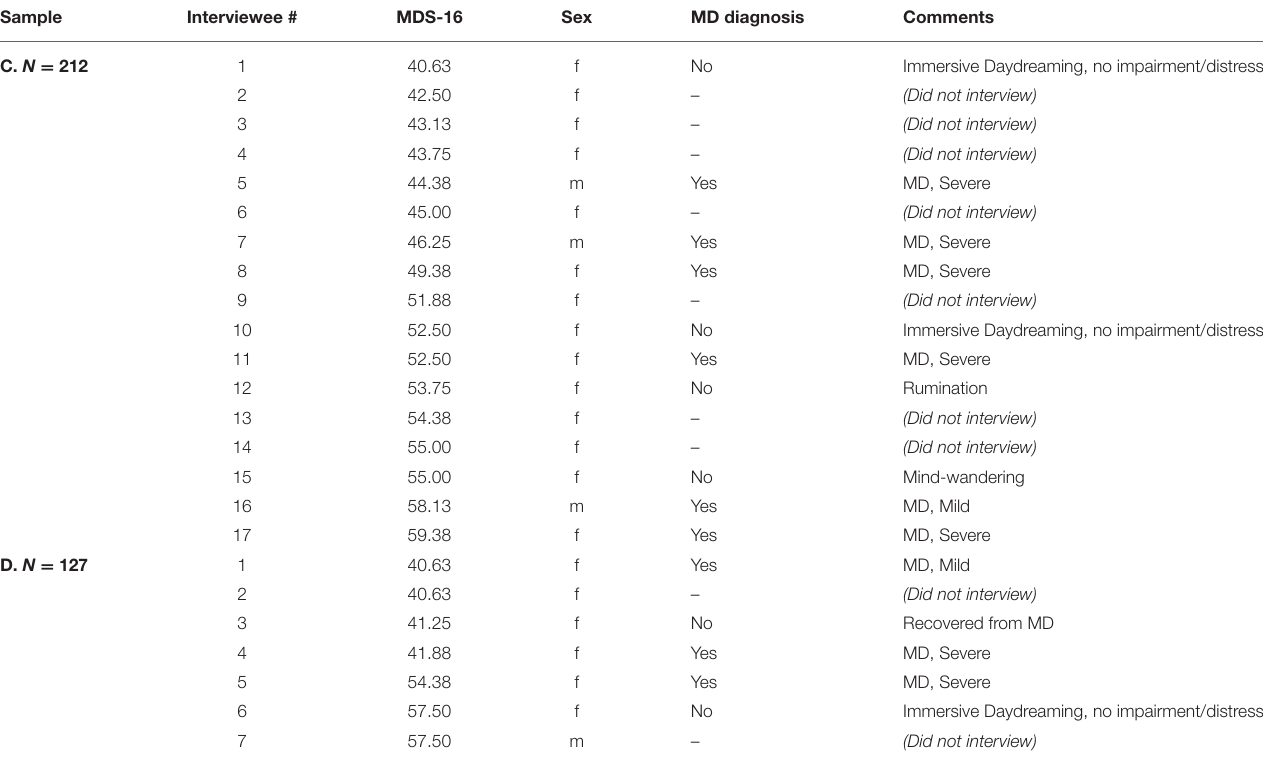
TABLE 4 | Results of diagnostic interviews for those exceeding the suspected cutoff for MD (MDS-16 score over 40) in Samples C and D.